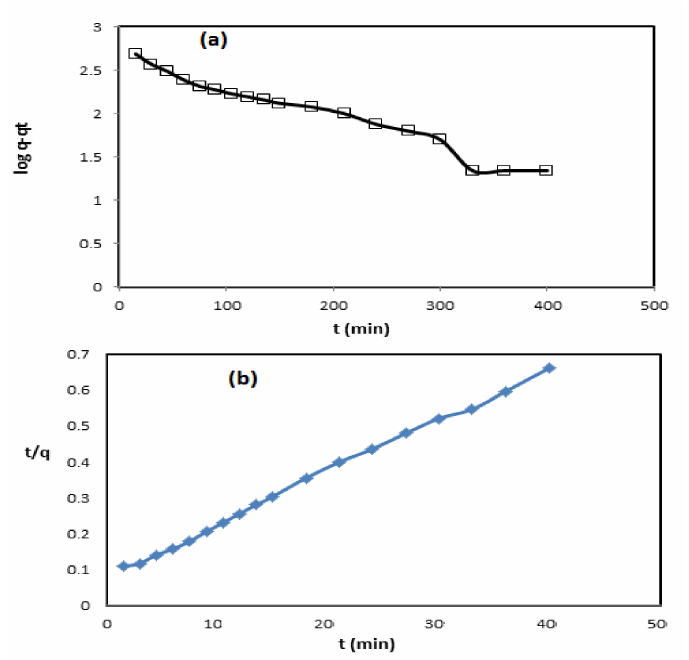
Figure 14. CR adsorption ( a ) pseudo-first-order; ( b ) pseudo-second-order kinetics models using QVP / AAm-Fe 3 O 4 at room temperature. Table2. KineticparametersofQVP / AAm-Fe 3 O 4 forremovalofCRfromaqueoussolutionattemperature 298 K.